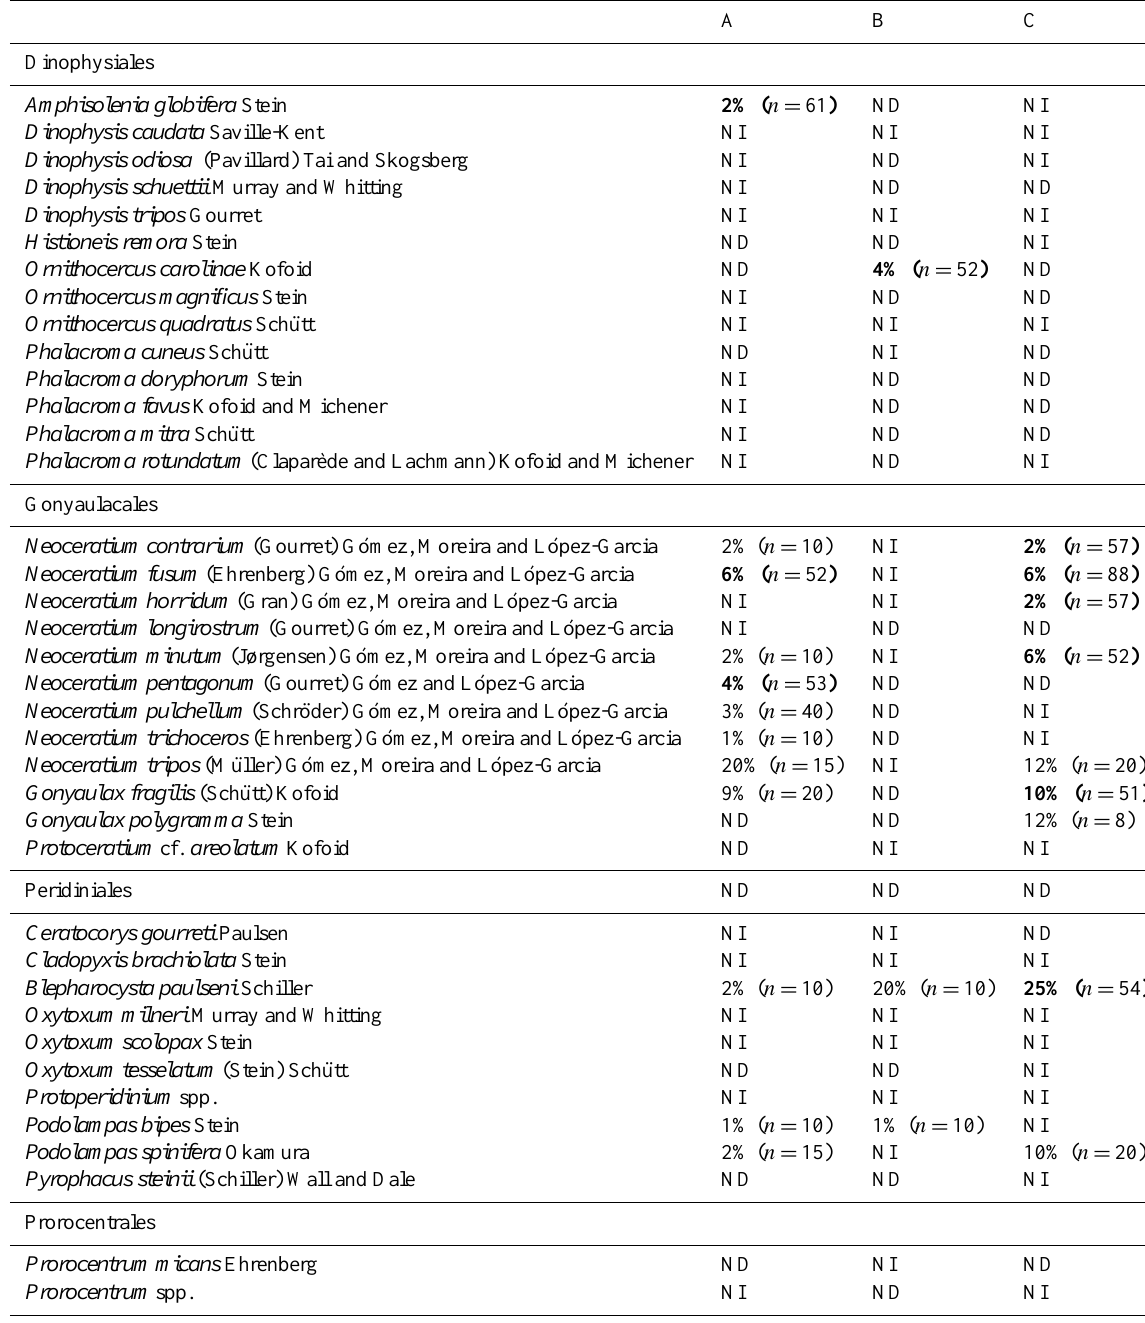
Table 1. List of infected and non-infected dinoflagellate species recorded at stations A, B and C. Species underlined are new potential hosts of Amoebophryidae. Number of examined specimens for the determination of prevalence (%) of infected species is showed in parenthesis. Significant prevalence values ( n > 50) are in bold. NI = dinoflagellate species present but non-infected; ND = dinoflagellate species non-